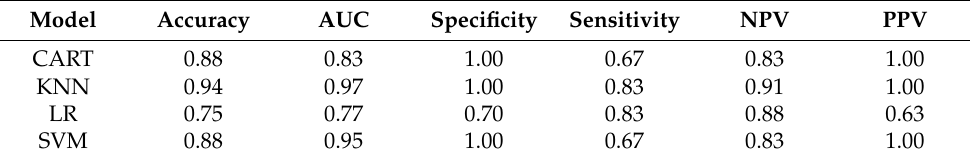
Table 3. Model performance